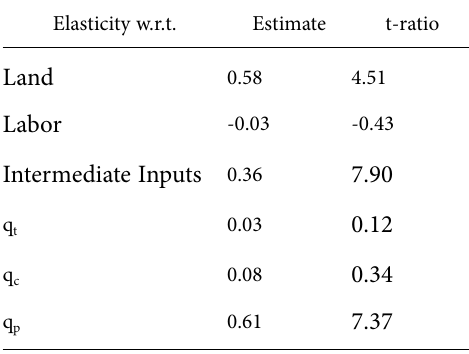
Table 5. Elasticities of estimated ray production function at sample mean Elasticity